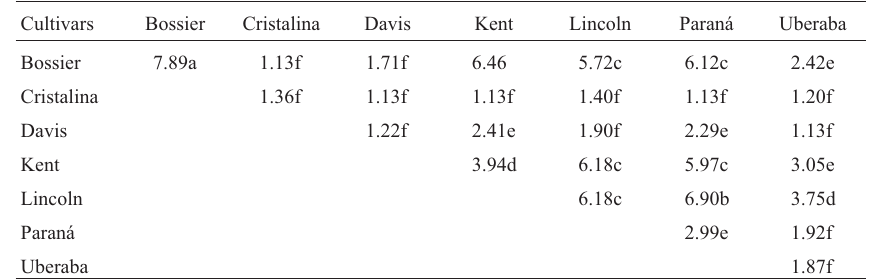
Table 1 - Estimated means for the multivariate index evaluated in the assay of soybean reaction to C. sojina involving seven cultivars and their 21 hybrid combinations, in a diallel cross 1/ .